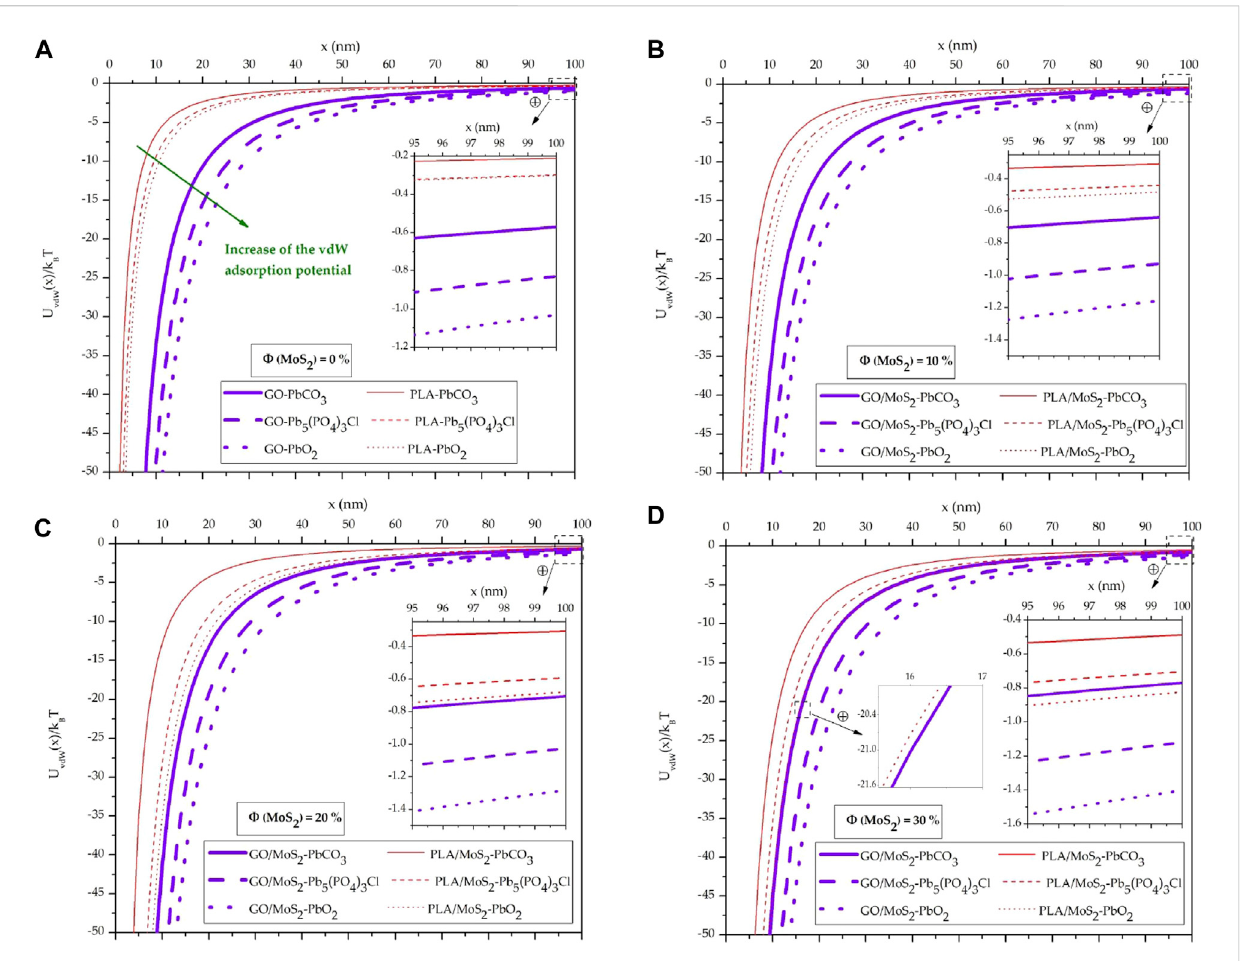
FIGURE 4 Evolution of the vdW adsorption potential between the GO/MoS 2 and PLA/MoS 2 nanocomposite adsorbents and the “ PbCO 3 , Pb 5 (PO 4 ) 3 Cl, and PbO 2 ” lead adsorbates in a water medium: (A) Φ = 0%, (B) Φ = 10%, (C) Φ = 20%, and (D) Φ = 30%.